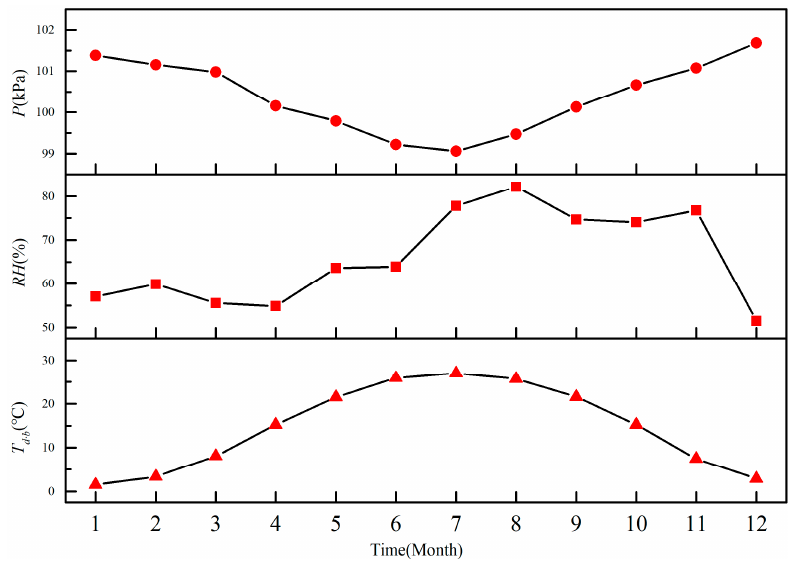
Figure 7. Parameters of a typical meteorological year in Zhengzhou.